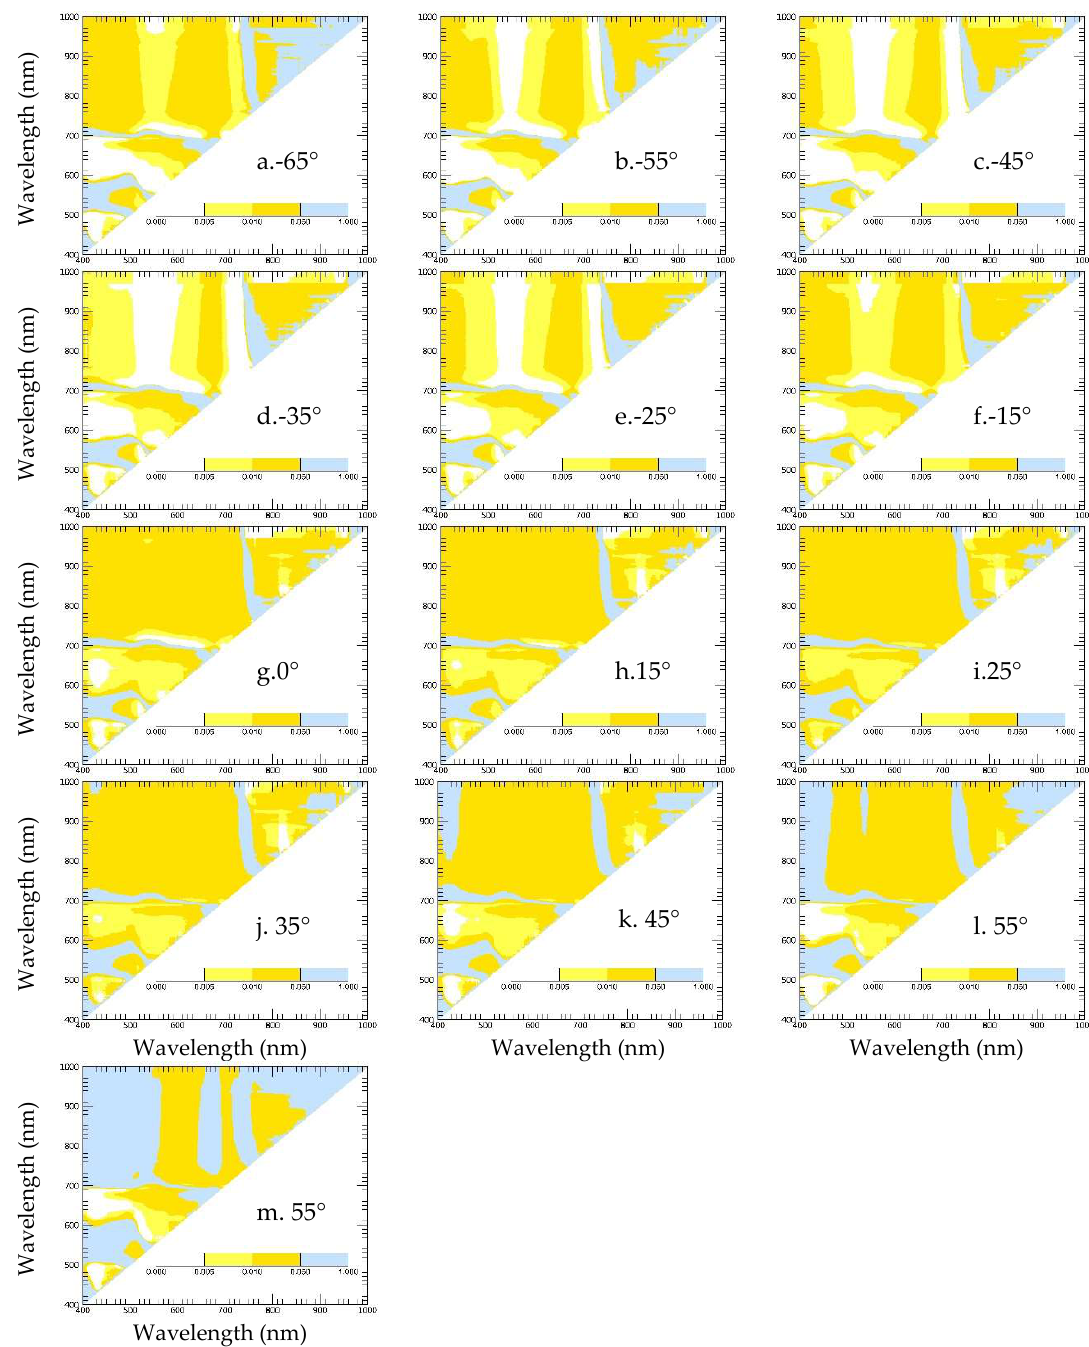
x, y correspond to index wavelengths. The best index for each plant type is highlighted in bold. NDSI with wavelengths of a green and a red-edge band are highlighted in gray. W9507: planophile variety, W411: erectophile variety.